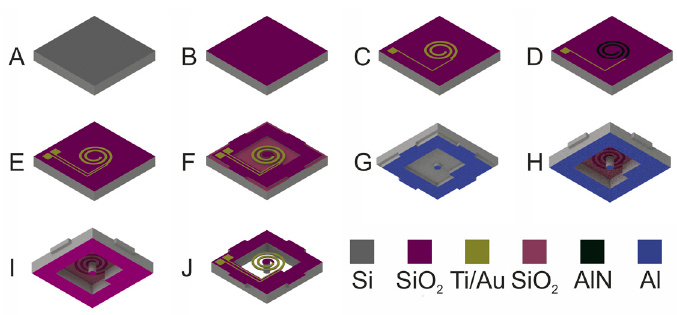
Figure 2. Schematics of the fabrication procedure: ( A ) 4” Si-on-Insulator (SOI) wafer; ( B ) thermal oxidation (300 nm); ( C ) deposition and lift-off of the bottom Ti/Au contact and pads; ( D ) radio frequency (RF) sputter deposition and patterned etching of aluminum nitride (AlN) (830 nm); ( E ) deposition and lift-off of top Ti/Au contact; ( F ) deep reactive ion etching (DRIE) of the spiral beam from the front side; ( G ) first DRIE Bosch process from the back-side and the strip of the photoresist mask; ( H ) second DRIE Bosch process from the back-side through the Al hard mask with a slightly modified pattern to obtain perforated Si frame; ( I ) etching of the Al masking layer; ( J ) hydrofluoric acid (HF) etching of the buried oxide and removal of the top protective photoresist layer.